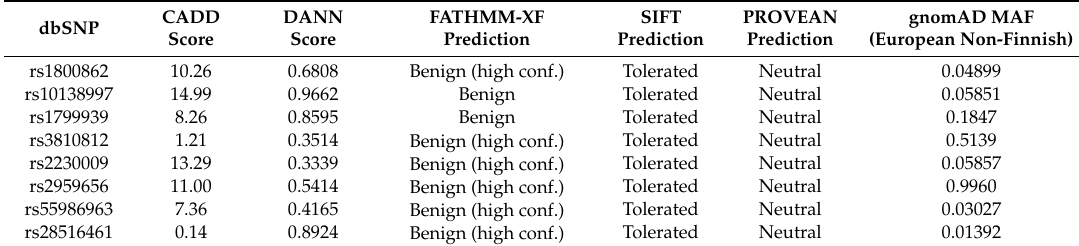
Table 2. Relative assessment of the variant